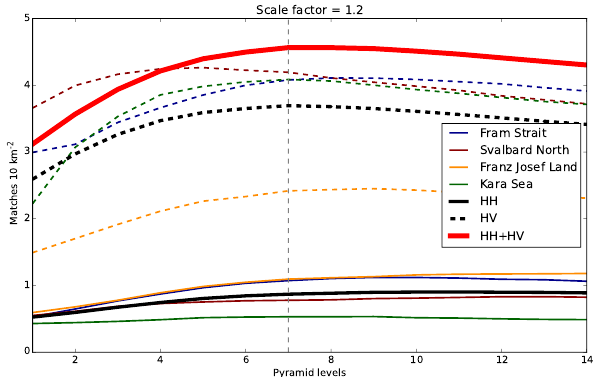
Figure 4. Number of pyramid levels vs. number of matches of the four test image pairs from Table 1 for a scale factor of 1.2. Solid and dashed lines represent results for HH and HV polarization. Mean values are shown in black and the sum of the mean values in red. Vertical grey line at 7 represents chosen number of pyramid levels.